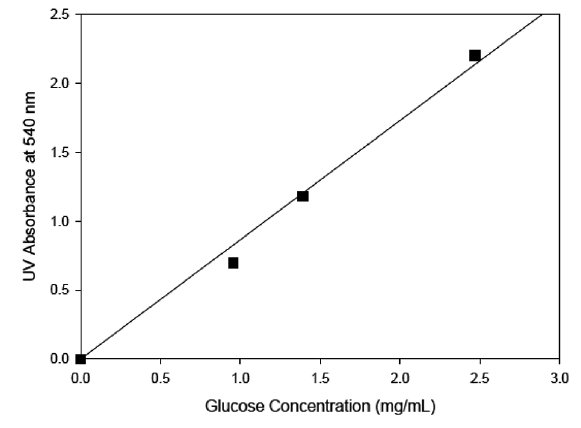
Figure 1. Standard calibration curve for determination of glucose concentration in hydrolysate